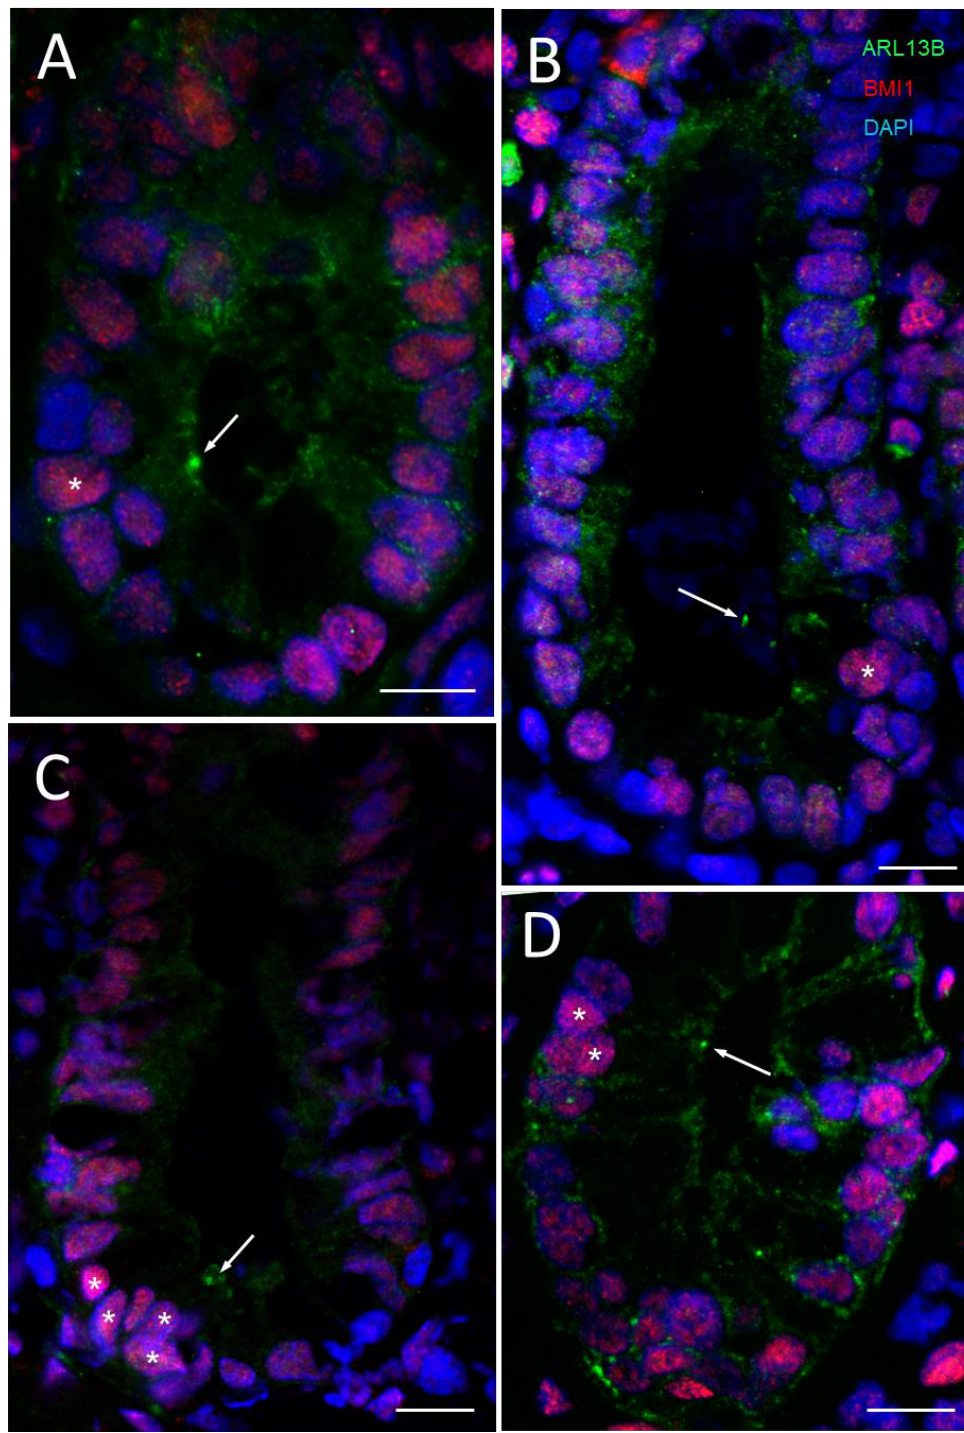
Figure 9. Primary cilia in association with BMI1-positive cells of the crypts of the human small intestine. ( A ) Representative immunodetection of primary cilia using the anti-ARL13b 90413h antibody (arrows, green staining) and positive BMI1 nuclei (red staining, stars) in epithelial crypt cells of the human adult small intestine. In some instances, single nuclei staining was observed to be more intensive for BMI1 in relation to the detection of cilia ( A , B ) while in other cases, a cluster of BMI1-positive nuclei coinciding with ARL13b-positive structures was noted ( C , D ). Nuclei were stained with DAPI (blue). Scale bars are equal to 10 µm.